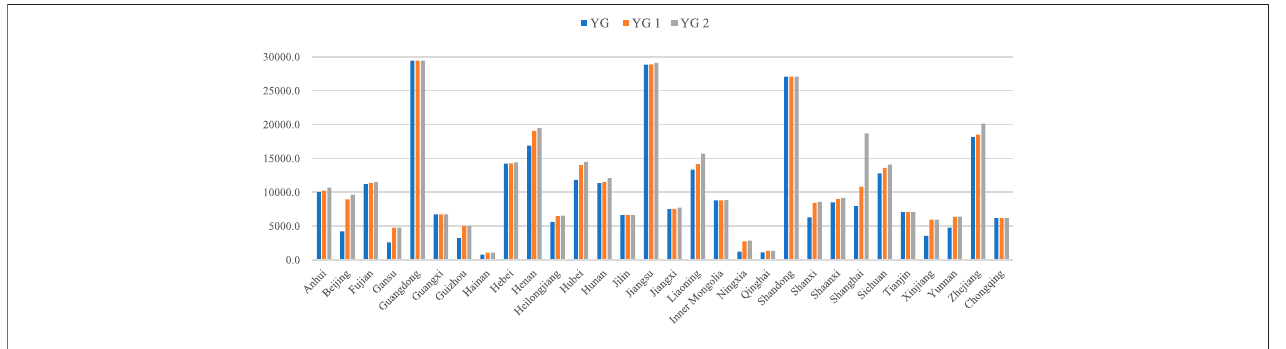
FIGURE 5 | Average projection comparison for YG in 30 provinces during 2011 –